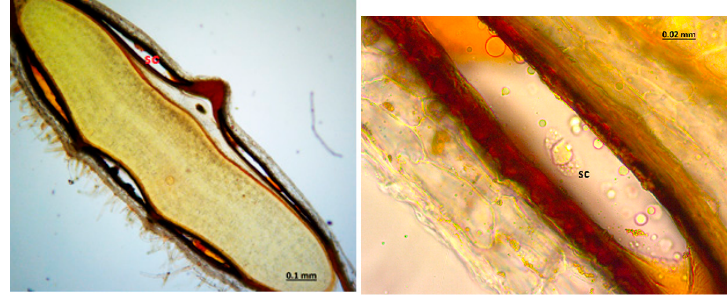
Figure 8. Secretory canals at the fruit of Zosima absinthifolia by light microscopy.